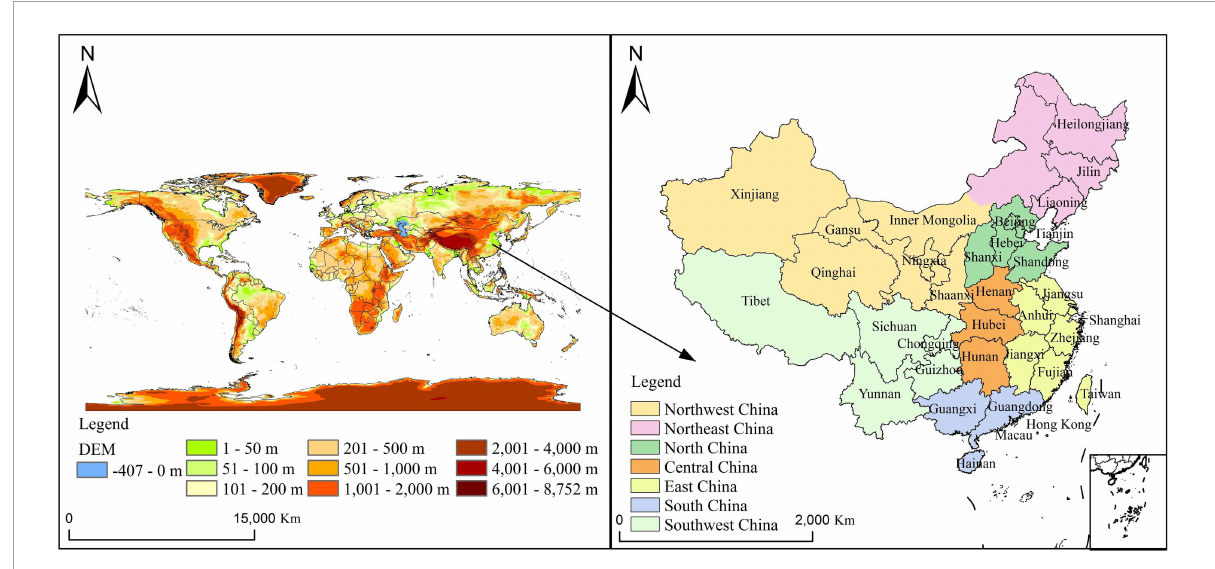
FIGURE1 Location of study